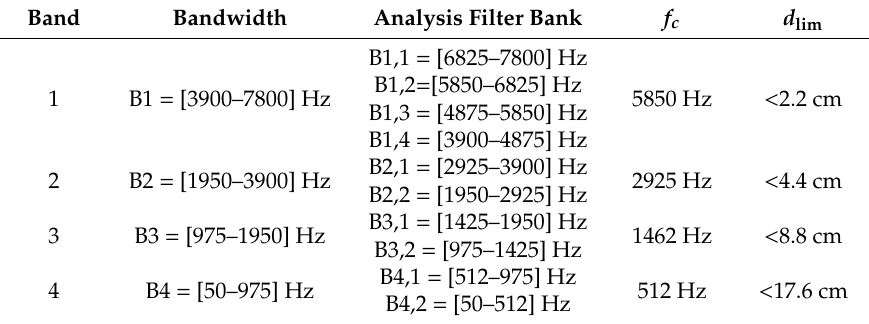
Table 1. The information to design the proposed uniform CNMA.